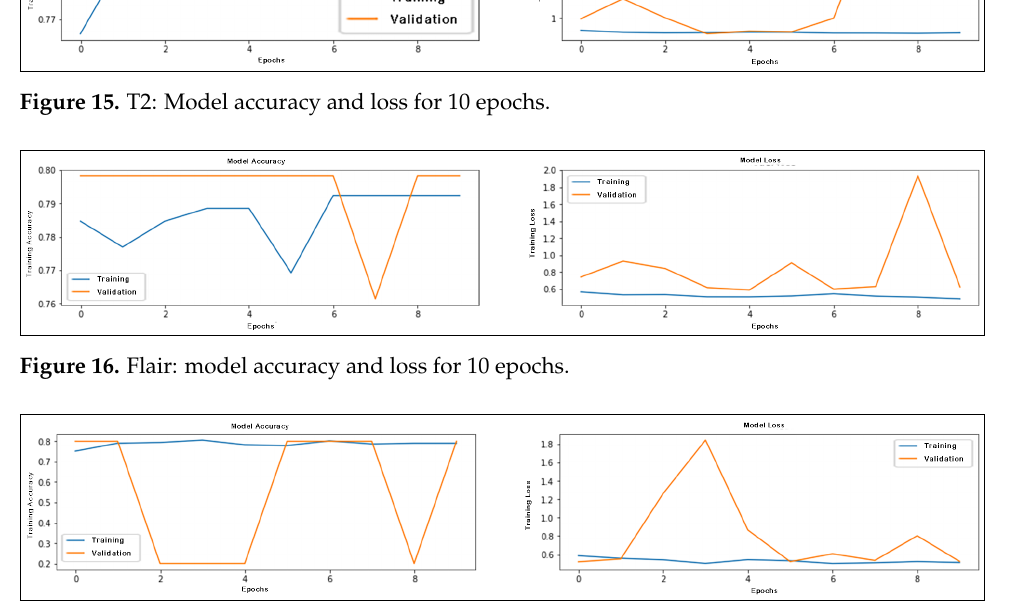
Figure 17. Segmented: model accuracy and loss for 10